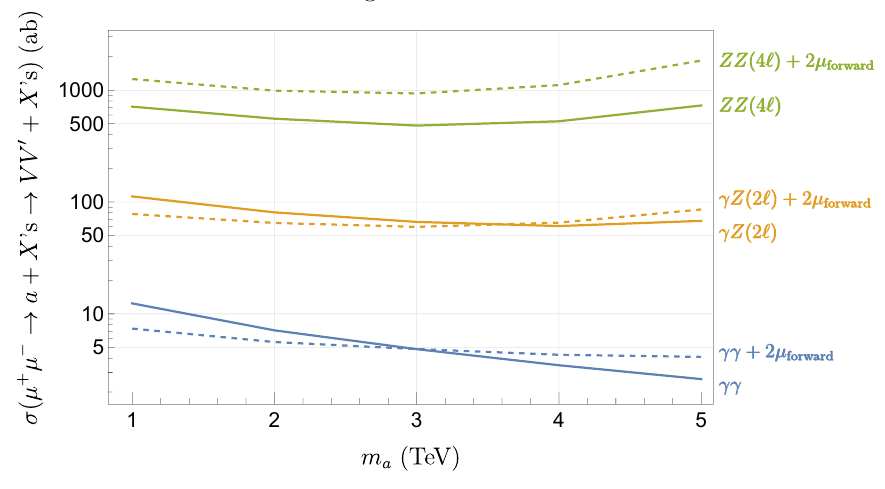
Figure 9 . Comparison between 2 σ exclusion limits with (dashed lines) and without the forward- muon number cut (solid lines, the same as figure 6) for reconstruction, we consider only channels with γ or Z → ‘ + ‘ − final